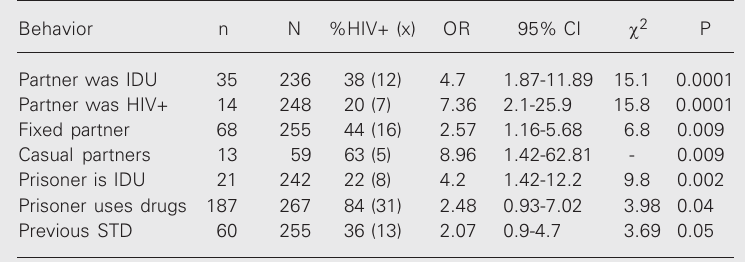
Table 6. Statistically significant risk behaviors for HIV infection after calculation of the odds ratio (OR) for each questionnaire variable related to HIV seropositivity. Behavior